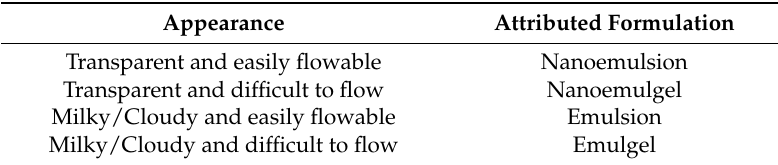
Table 6. Categorization